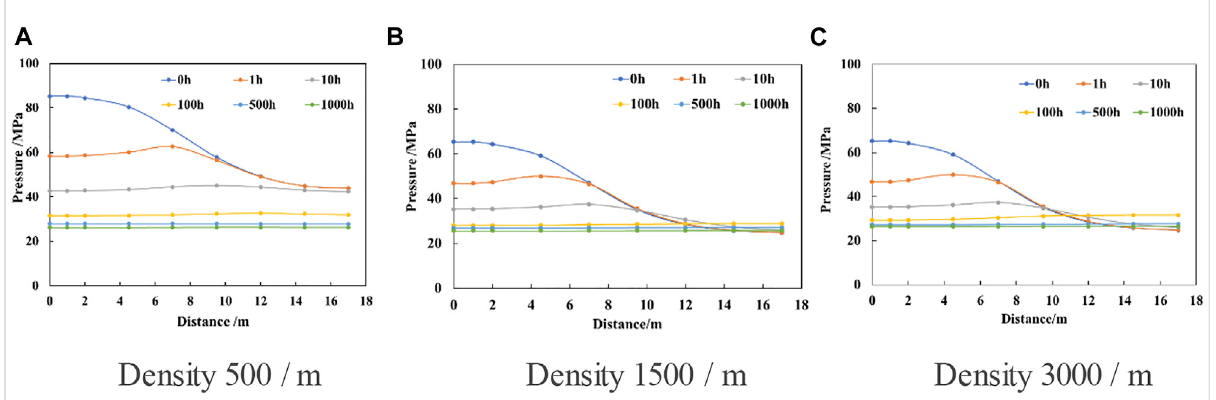
FIGURE 21 Pressureofthemainfractureatdifferenttransversedistancesindifferentlamellation-fracturedensities. (A) Density500 m; (B) Density1,500 m; and (C) Density 3,000